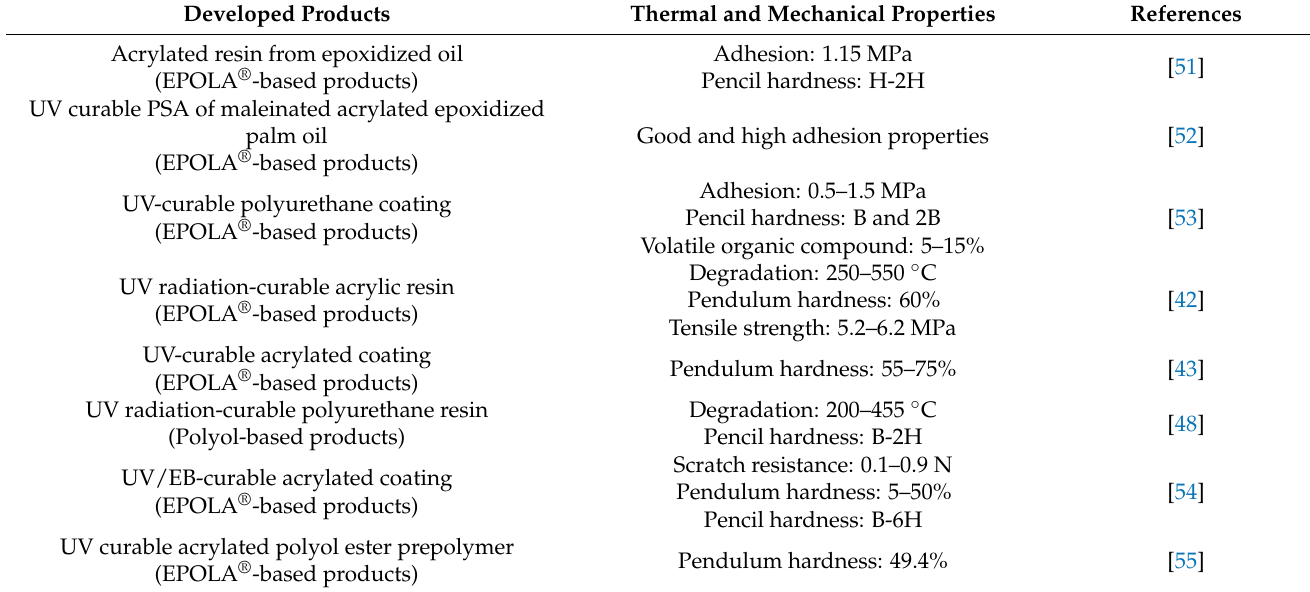
Table 2. The thermal and mechanical properties of the EPOLA ® and polyol-based